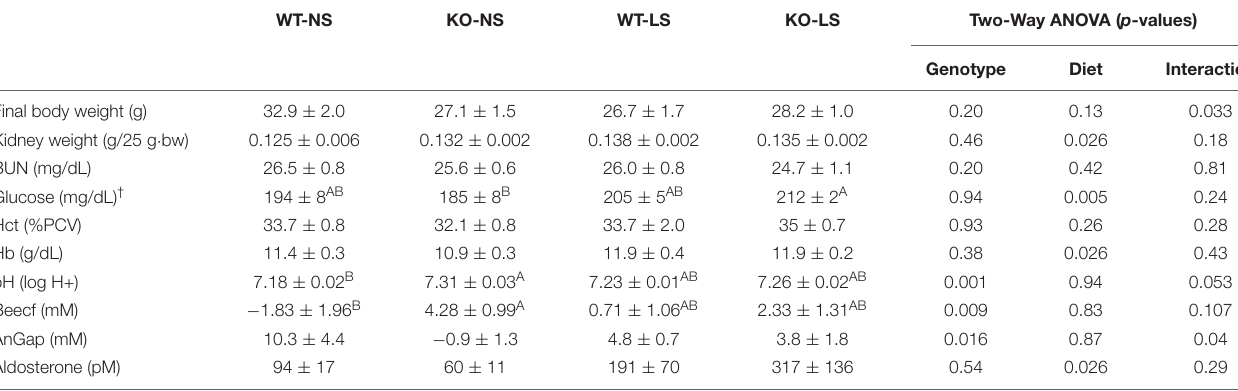
TABLE 1 | Weight and Blood Parameters in male CD-PC mTOR KO mice under normal and low-NaCl